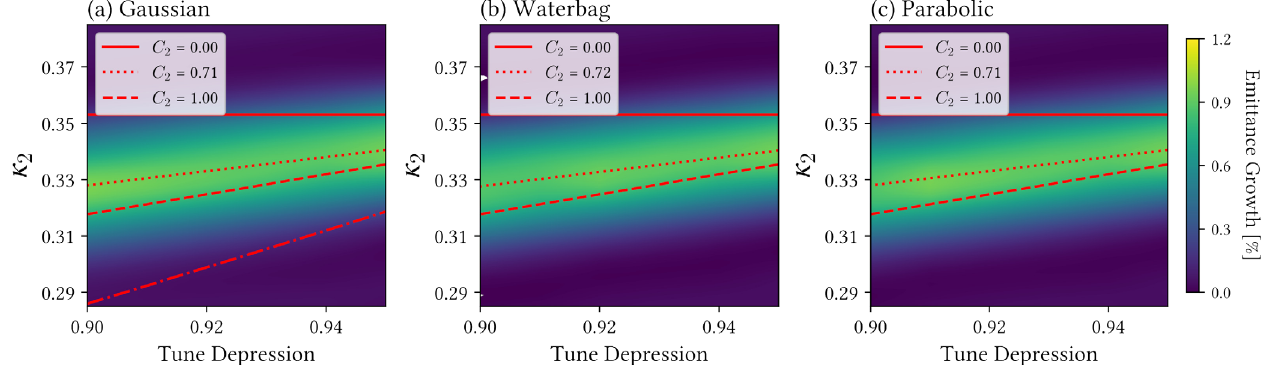
FIG. 15. Emittance growth chart of the sum resonance with ð k; l Þ ¼ ð 1 ; 1 Þ excited by the linear driving perturbation. The perturbation amplitude is set at 0.1% of the focusing field ’ s in these W ARP simulations. The solid and dashed lines correspond to the cases where C ¼ 0 (single-particle resonance) and C ¼ 1 . The dotted line is the location of the stop-band peak fitted by Eq. (15) with C 2 2 for Gaussian and parabolic, and C 2 ¼ 0 . 72 for waterbag. The dash-dotted line in the left panel indicates the incoherent resonance line for a particle with the maximum tune shift.